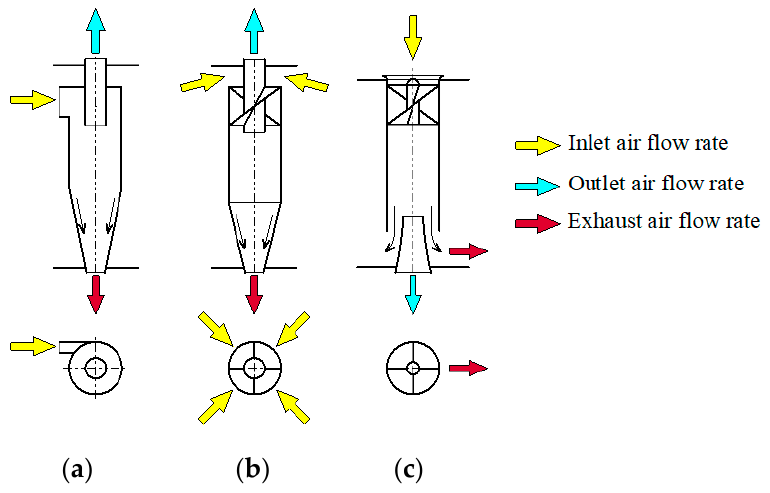
Figure 1. Types of cyclones used for filtering the intake air in motor vehicles: ( a ) reverse-flow cyclone ( b ) return with axial inlet, ( c ) axial flow (vortex tube separators).